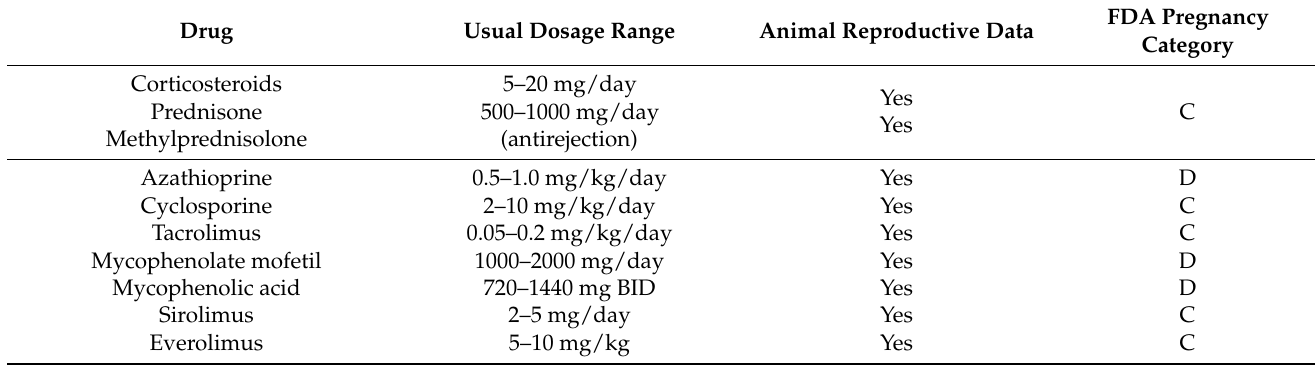
Table 4. Immunosuppressive drugs used in